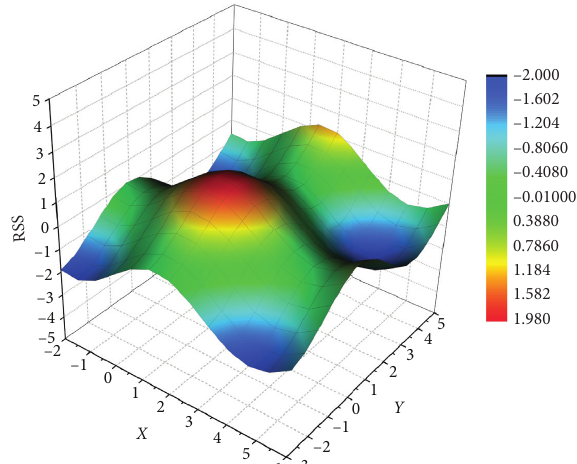
Figure 6: RSS distribution of grid